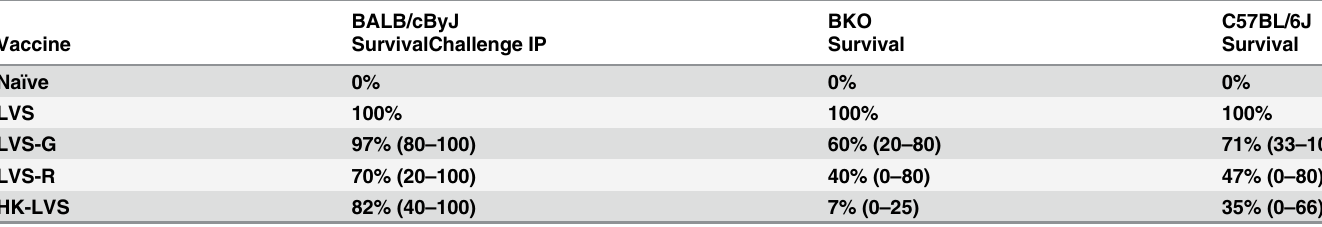
Table 1. Effect of differential vaccination on survival against lethal challenge with